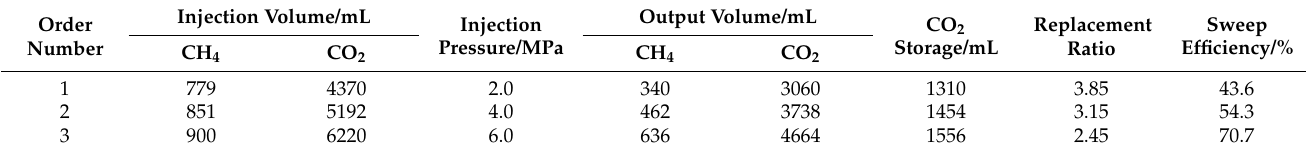
Table 2. The experimental results of displacement of CH 4 by CO 2 .